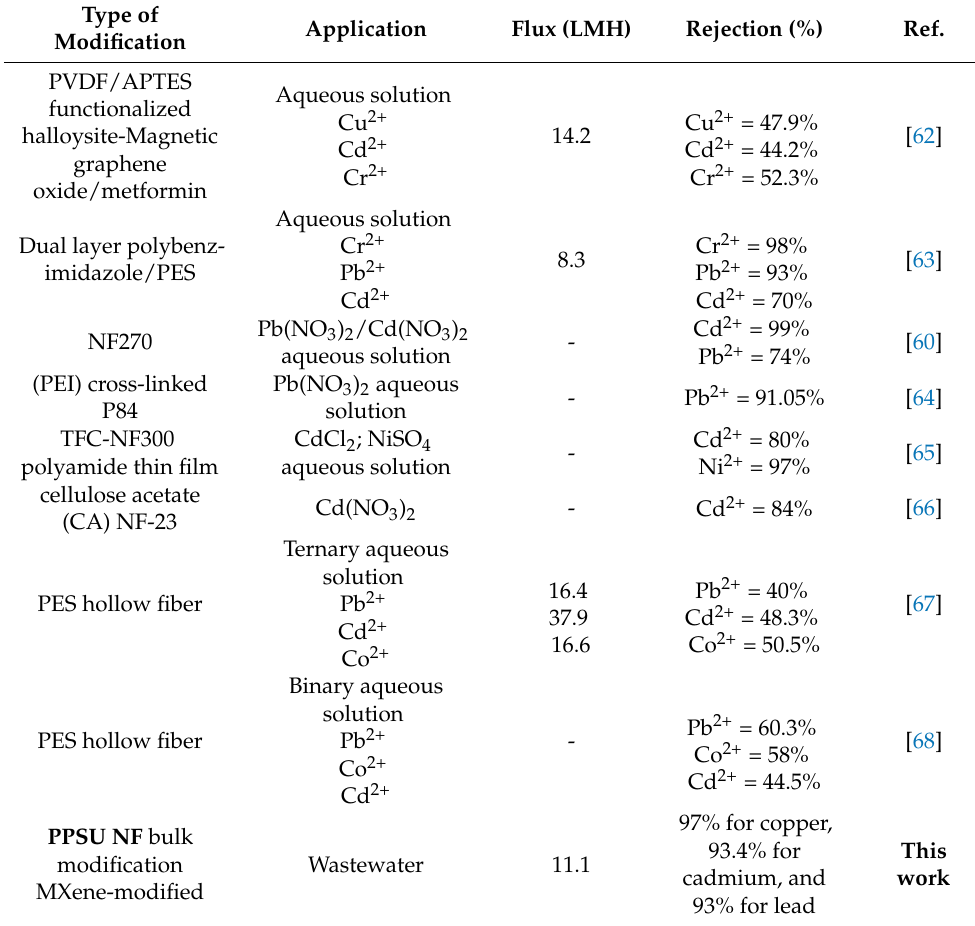
Table 3. Comparison of preceding studies with current work in terms of membrane performance for heavy metals